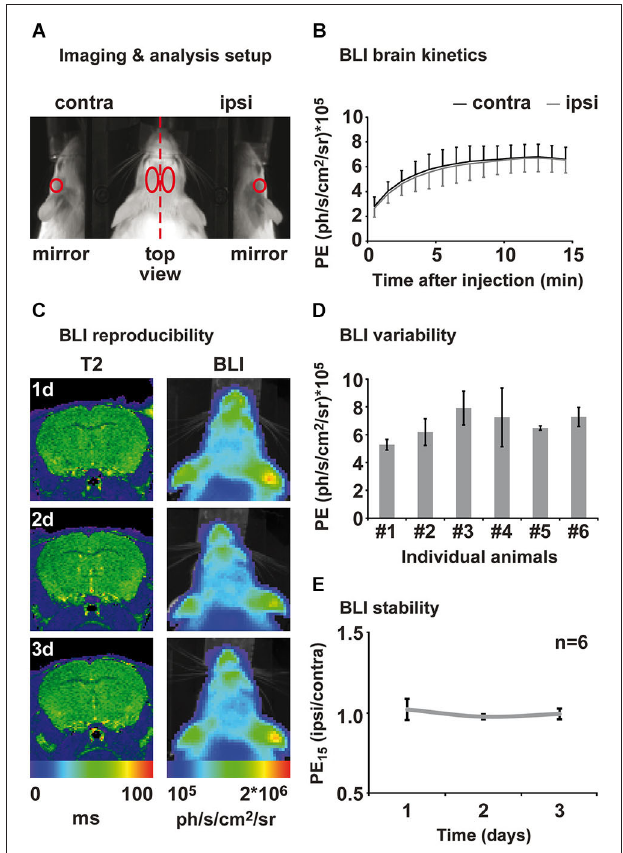
FIGURE 2 | Assessment of brain kinetics and stability of the BLI signal from healthy animals. (A) Animals were placed in a prone position on an elevated bar between two 45 ◦ mirrors. BLI was evaluated in four different regions of interest: ipsi- and contralateral top view, ipsi- and contra-lateral mirror (side) view. (B) Measuring PE directly after luciferin injection reveals brain specific inflow kinetics. An inflow phase between 1–10 min can be distinguished from a plateau phase of maximal PE between 12 and 15 min after injection. Emission from ipsi- and contralateral hemisphere was consistently of same magnitude. (C) Healthy control animals were measured repetitively for the assessment of the inter- and intra-animal variability of the BLI signal. MRI and BLI images of an exemplary healthy animal show an intact brain and stable intensity of PE over time. MRI is shown as coronal brain section, BLI is shown as horizontal planar projection of the PE onto the mouse photograph. (D) Three-fold measurement of each healthy animal revealed intra-individual variability of 3–30%. Inter-animal variability was around 20% to 45%. (E) Normalization of PE from ipsi- to contralateral hemisphere eliminates intra- and inter-animal variability and results in stable bioluminescence over time. Data is presented as mean ± standard deviation. (PE: photon emission, PE15: photon emission of the 15th minute after luciferin